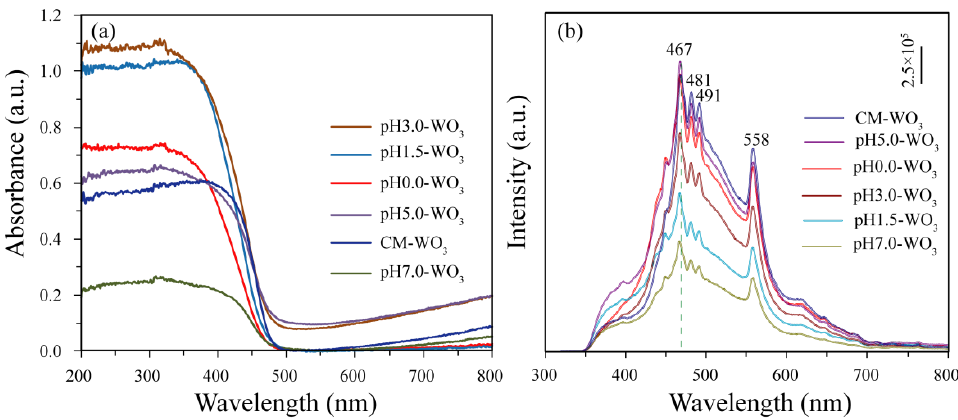
Figure 8. ( a ) UV – vis absorption spectra and ( b ) PL spectra of as-prepared pH x -WO 3 and CM-WO 3